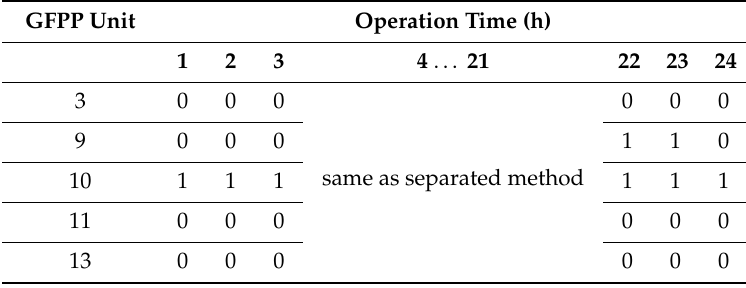
Table 3. Commitment status of GFPPs in integrated method.